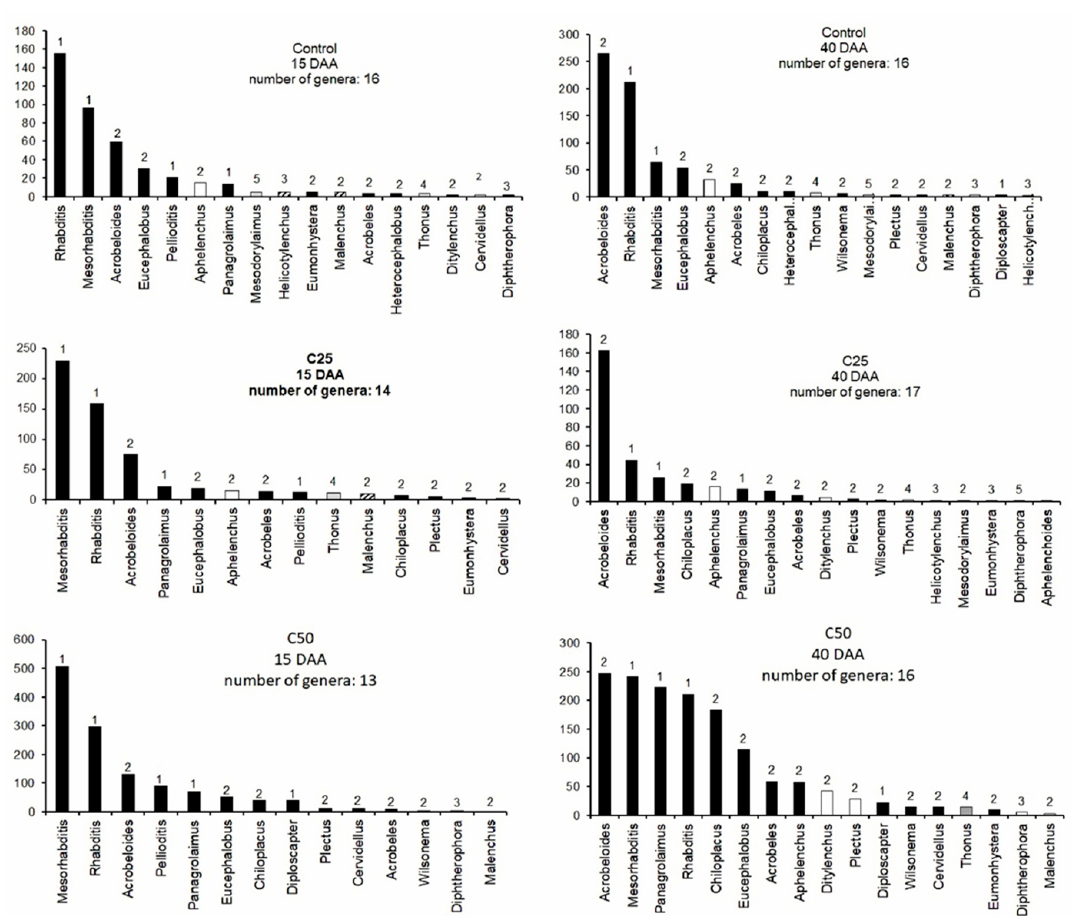
Figure 5. Rank abundance graphs for nematode genera in the community for each treatment in both sampling occasions. Numbers above the bars correspond to the c-p value of each genus. (Bar color: Black-bacterial feeders, White-fungal feeders, White with Diagonal pattern-plant feeders, Grey-omnivores).